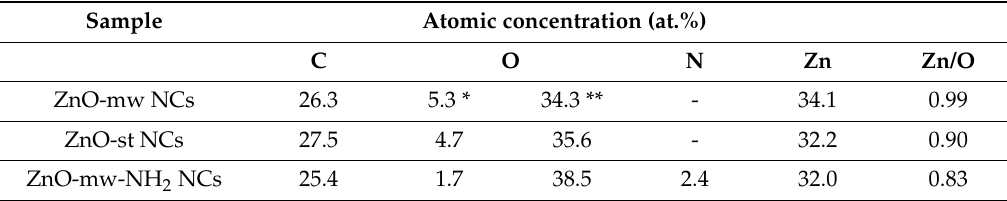
Table 2. XPS relative atomic concentration (at.%) from survey data, together with Zn/O calculation in the last column. * Amount of oxygen, in atomic percent, that is associated with carbon (from survey data). ** Total amount of oxygen, from the survey, minus the amount of oxygen associated with carbon in atomic percent. Sample Atomic concentration (at.%) C O N Zn Zn/O ZnO-mw